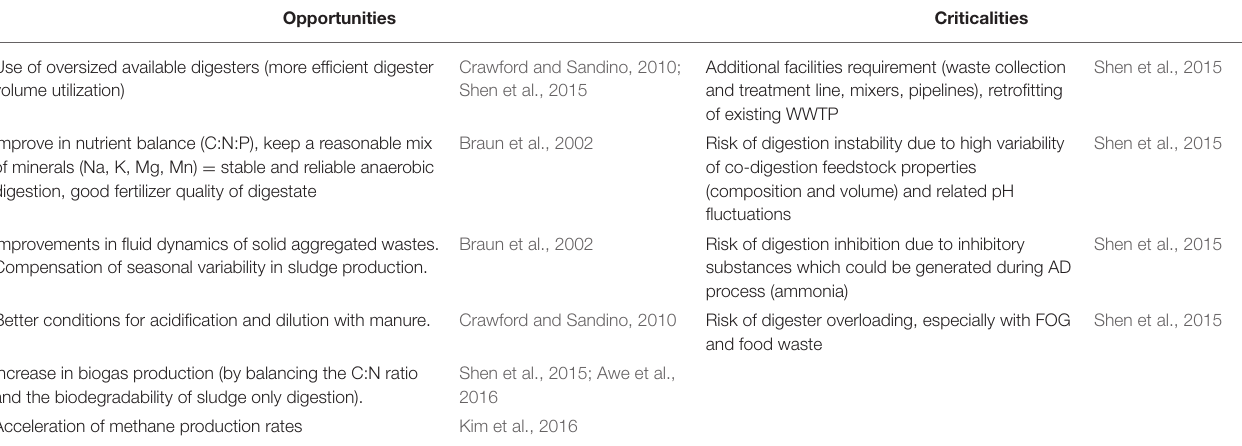
TABLE 5 | Opportunities and criticalities of sludge co-digestion.